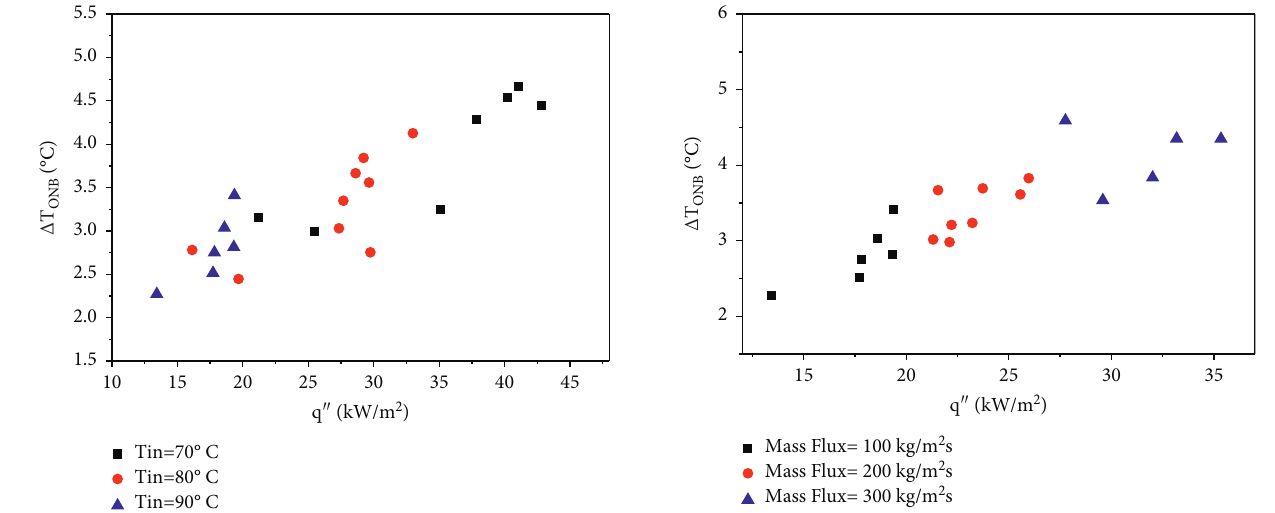
in channel b ( T : 90 ° ONB in